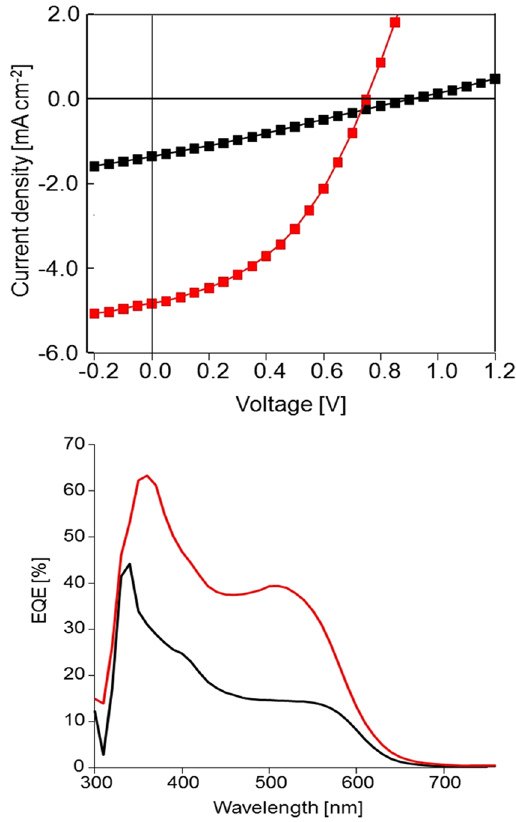
Figure 9. Top: Current density vs voltage curves of a bi-layer cell donor/C 60 under AM 1.5 simulated solar light (80 mW cm − 2 ). Black square: untreated cell, red squares: after 10 min TT at 140 °C. Bottom: EQE spectra of the same cell before (black) and after (red) TT.